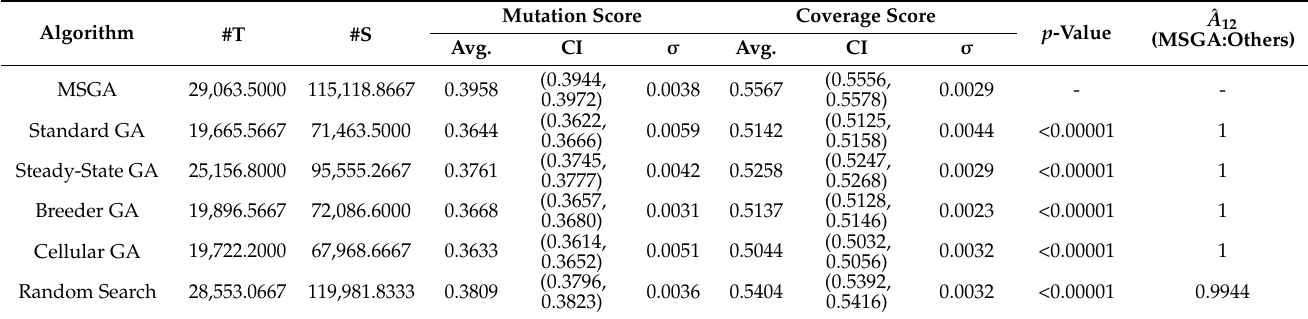
Table 2. Results of generating a whole test suite using each